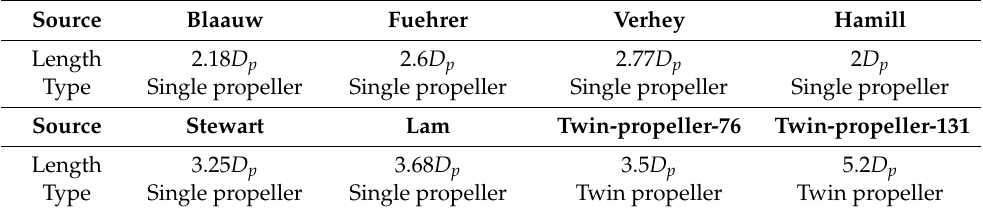
Table 5. Length of